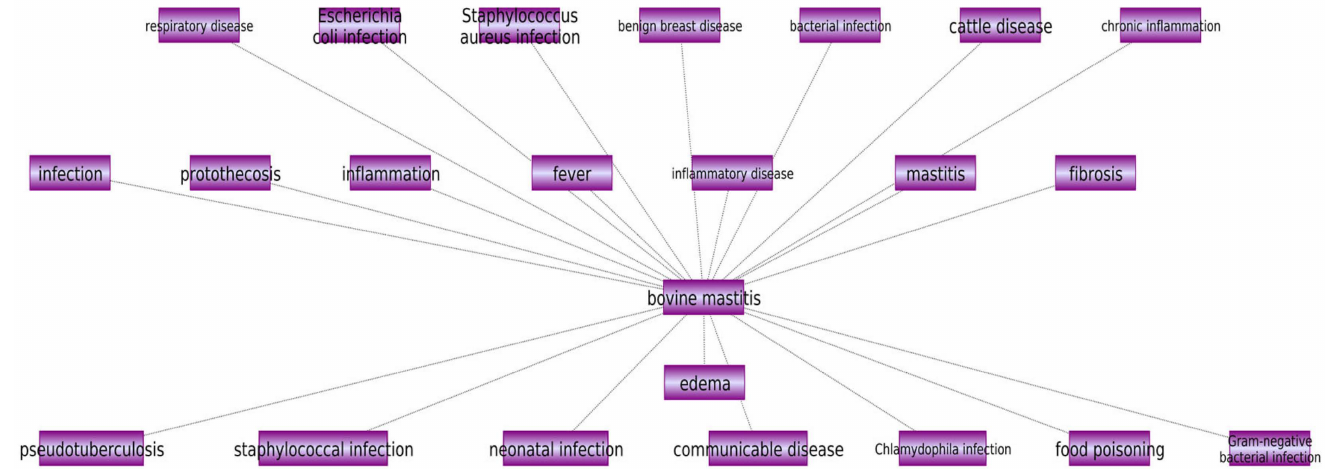
Figure 2. Disease network related to mastitis constructed by using Pathway Studio web tool (based on at least two